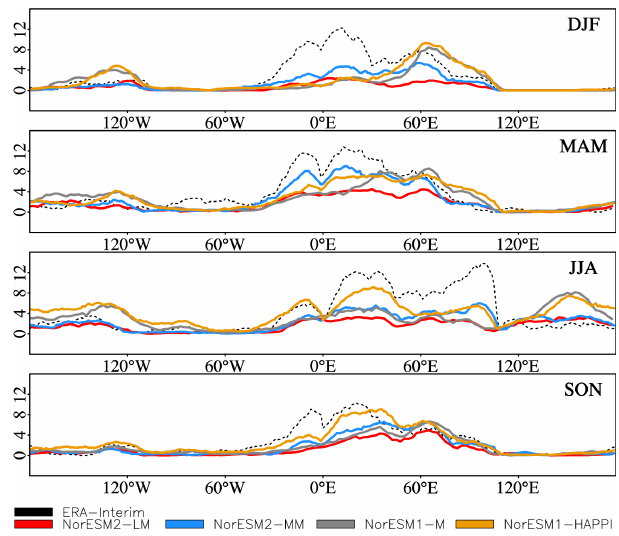
Figure 20. Ensemble-mean seasonal blocking frequency in the Northern Hemisphere for ERA-Interim (stippled black line; years 1980–2009), NorESM2-LM (solid red line; years 1980–2009), NorESM2-MM (blue line; years 1980–2009), NorESM1-M (grey line; years 1976–2005), and NorESM1-Happi (yellow line; years 1976–2005). The model data are taken from the CMIP6 histori- cal members for NorESM2-LM (three members) and NorESM2- MM (three members) and from the CMIP5 historical members for NorESM1-M (three members) and NorESM1-Happi (three mem- bers). The blocking frequency is computed using the vTM index (Tibaldi and Molteni, 1990; Pelly and Hoskins, 2003; Iversen et al., 2013; Graff et al., 2019). Units are %.